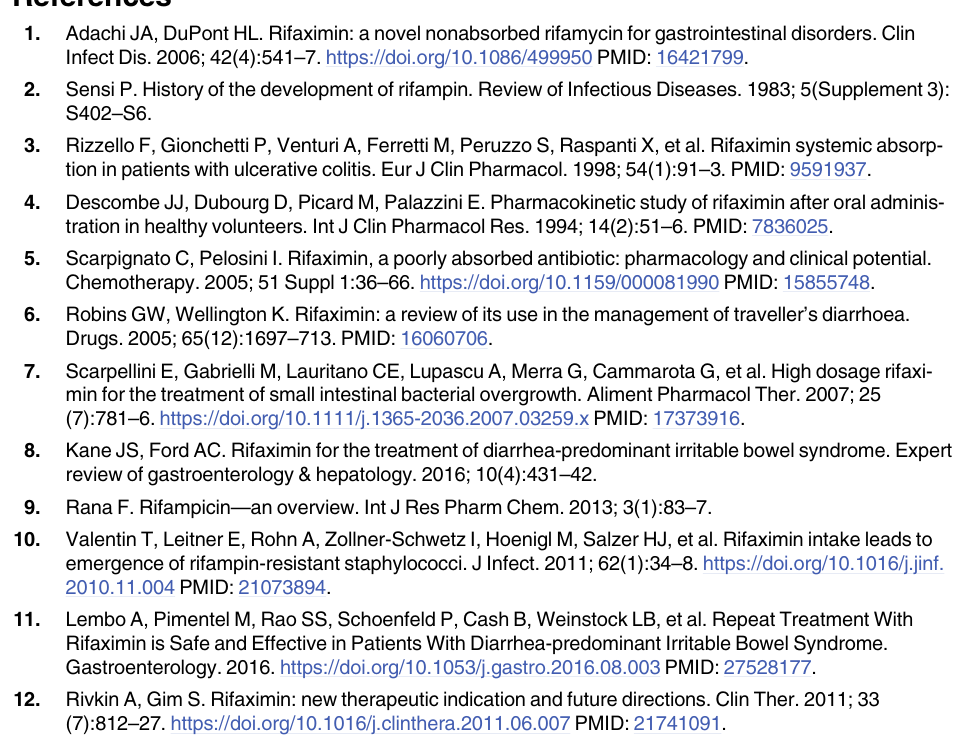
S1 Fig. Different kinds of staphylococcal isolates detected from hand (A) and perianal skin